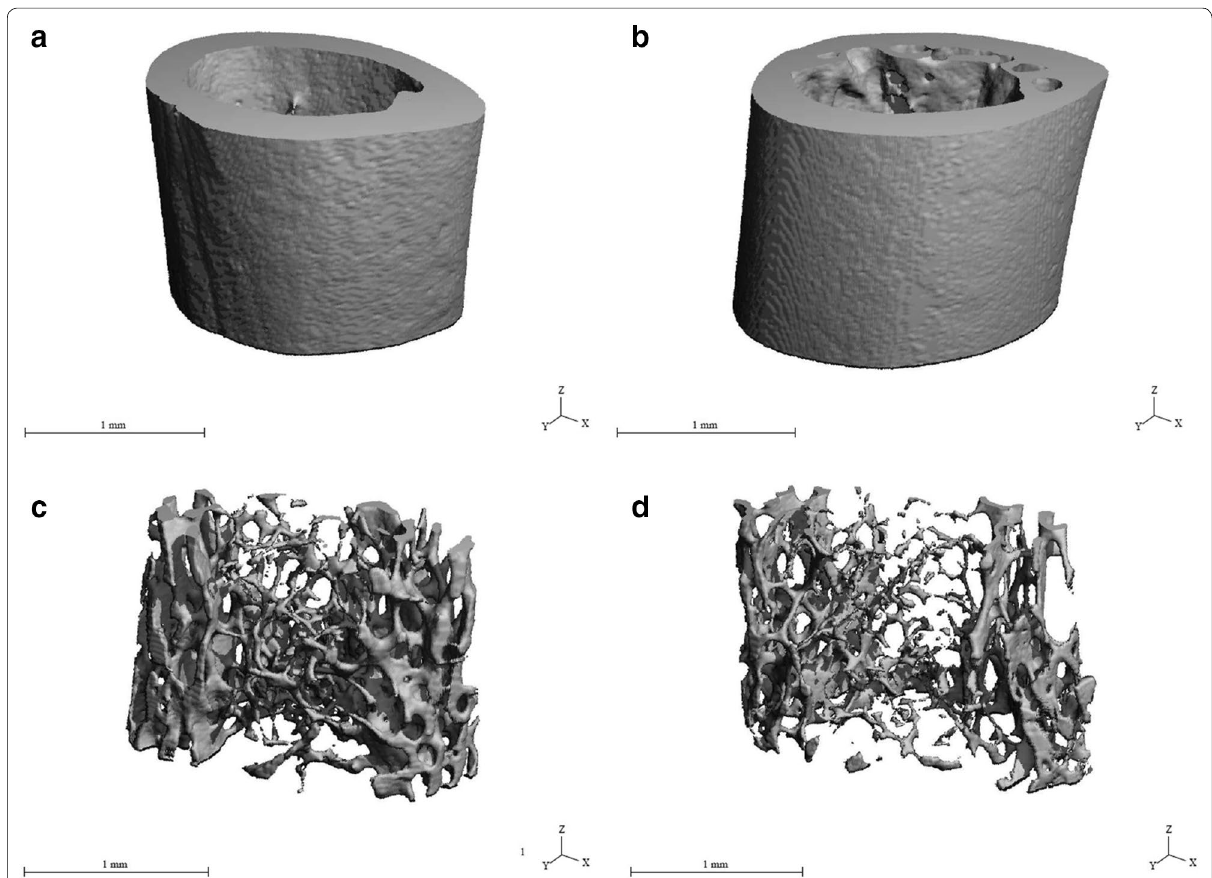
Fig. 2 a Representative reconstructed 3D image of compact bone in mice from group C. b Representative reconstructed 3D image of compact bone in mice from group E. c Representative reconstructed 3D image of trabecular bone in mice from group C. d Representative reconstructed 3D image of trabecular bone in mice from group E